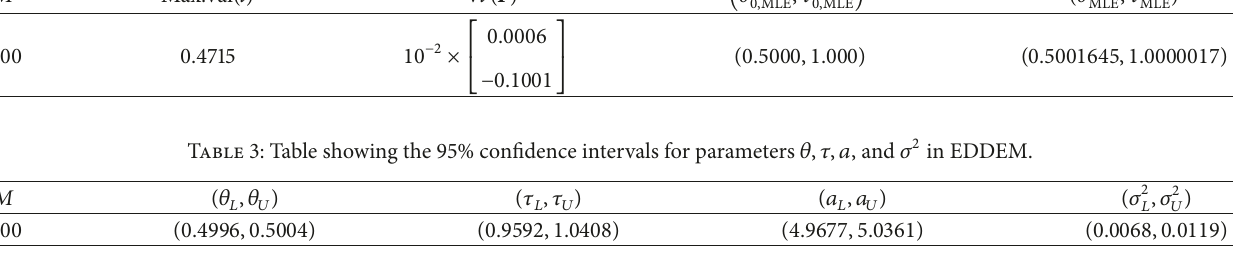
̂𝜃 , ̂𝜏 ) for the EDDEM with ℎ = 0.1 . MLE MLE